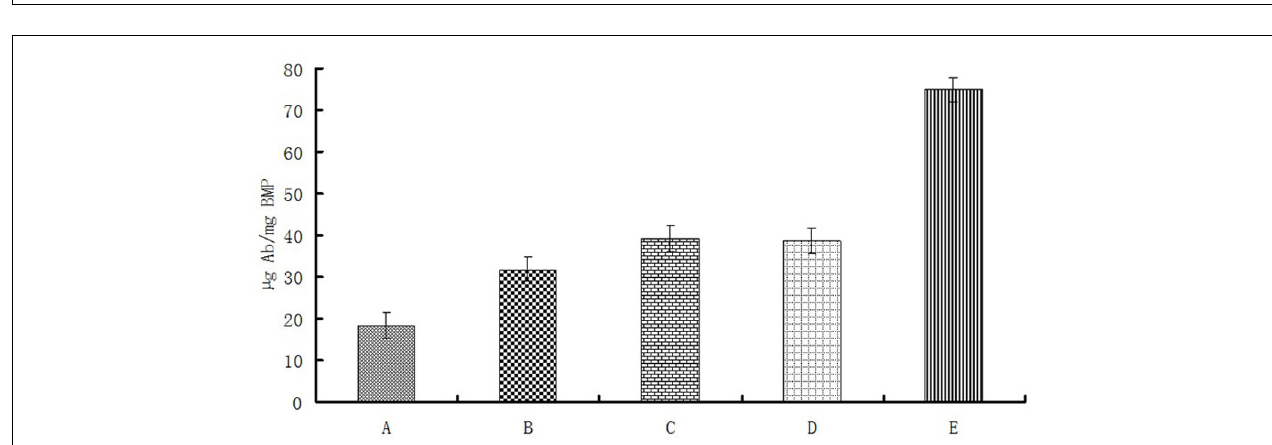
FIGURE 4 | Optimization of conditions for linkage of BMP-CA to Ab.